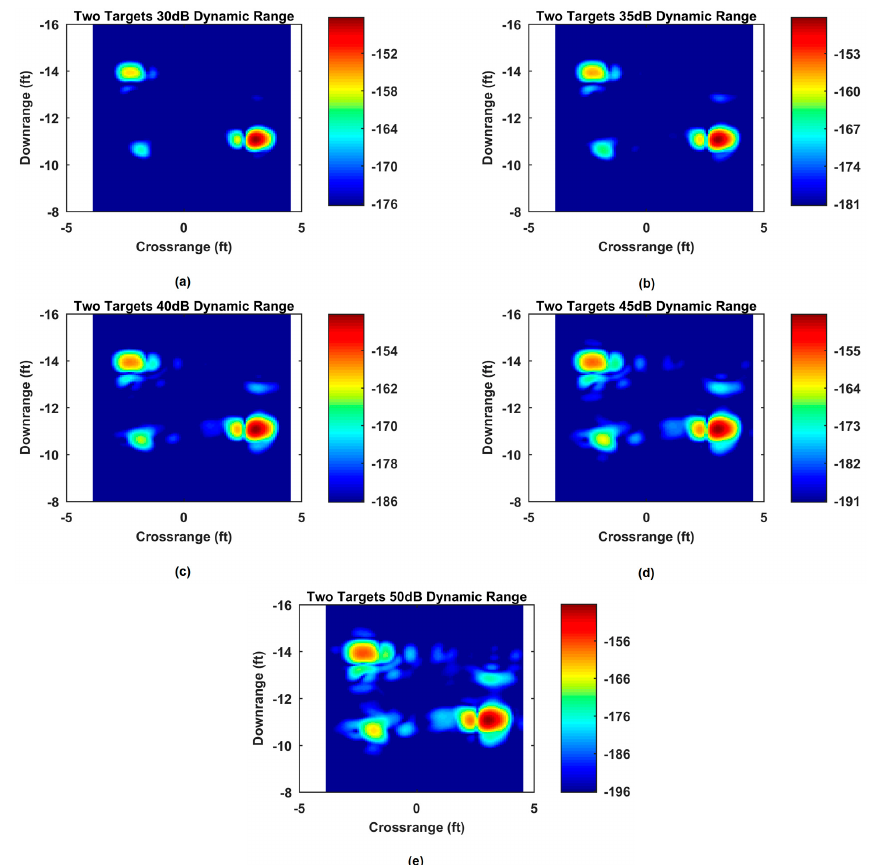
Figure 15. Fused images of multiple targets over 30–50 dB image dynamic range: ( a ) 30 dB; ( b ) 35 dB; ( c ) 40 dB; ( d ) 45 dB; ( e ) 50 dB.